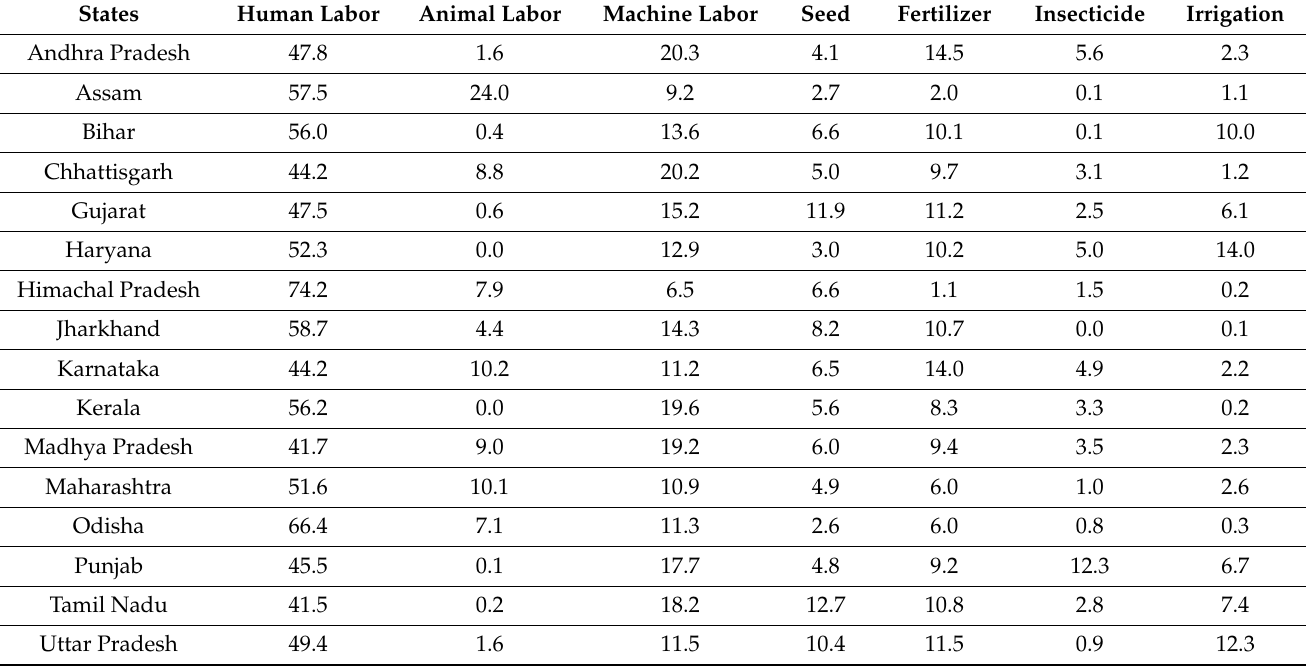
Table 5. Proportion of different input costs in the total operational/variable cost in paddy cultivation in India for 2016–2017. States Human